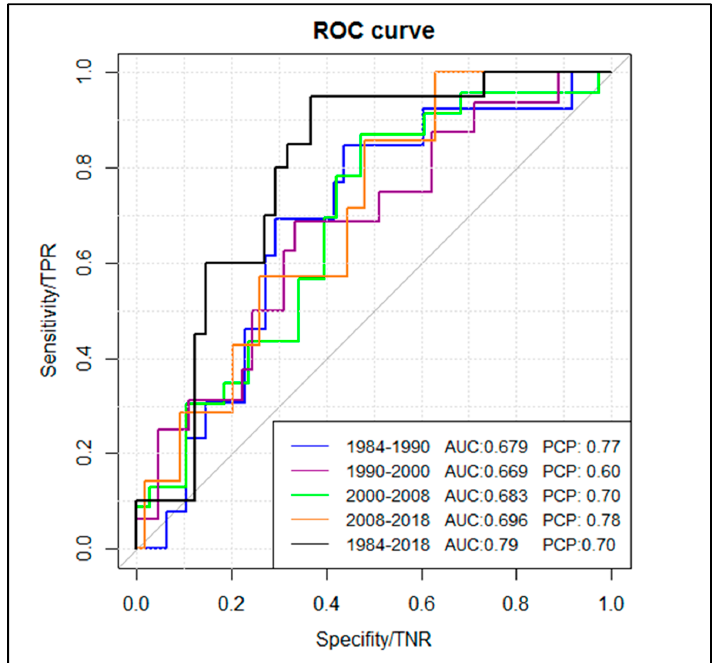
Figure 5. Receiver–operating–characteristic (ROC) curves conveying binomial logistic regression analyses results for urban growth from 1984 to 2018 within the Harare Metropolitan Province (TPRs: true positive rates; TNRs: true negative rates; AUC: area under the curve; PCPs: percentage of correct predictions).